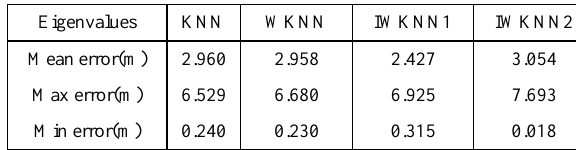
Table 3. Positioning results when using the true coordinates of fingerprint points.